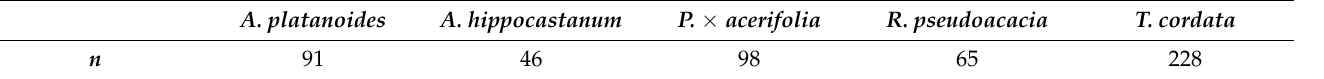
Table 3. Number ( n ) of measured trees included in the crown shape analyses.